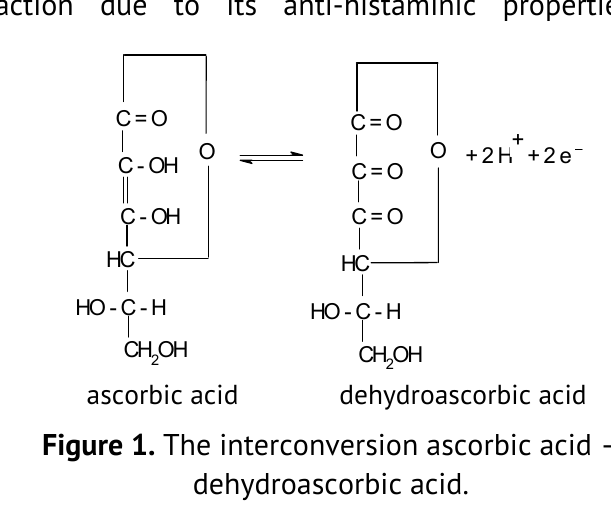
Figure 1. The interconversion ascorbic acid – dehydroascorbic